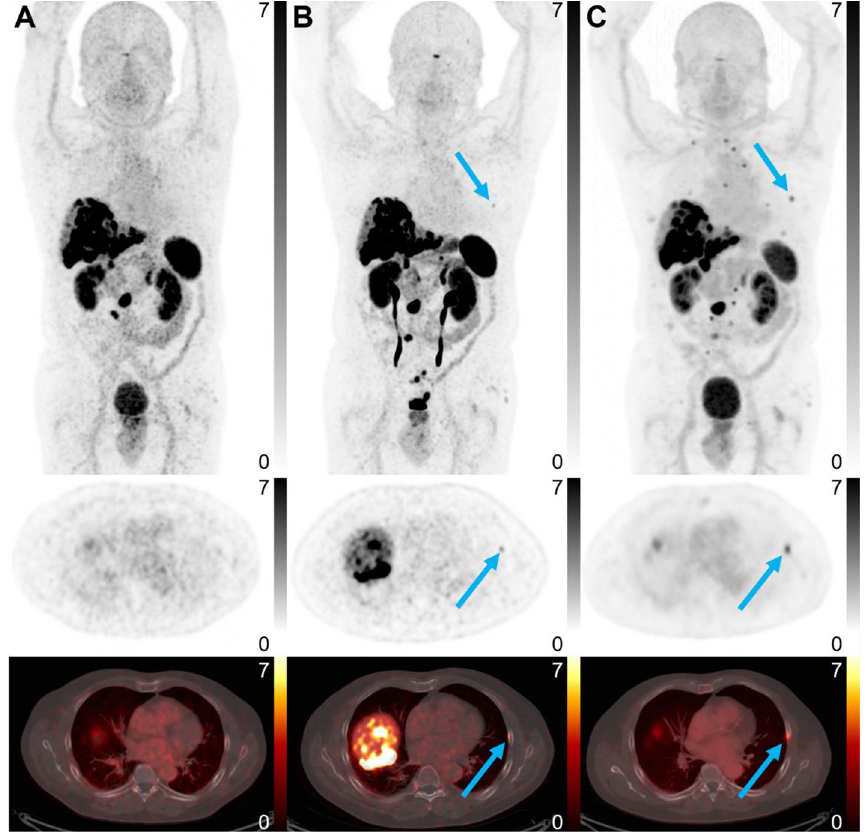
Fig. 4 A 68 Ga-DOTANOC and B 18 F-AlF-OC images (from top to bottom: maximum-intensity projection PET, transversal PET and fused PET/CT images, respectively) of a seventy-year old male patient with an intestinal neuroendocrine tumor with multiple liver metastases and one involved lymph node. 18 F-AlF-OC detected an additional bone lesion (blue arrow) that was confirmed by C follow-up 68 Ga-DOTANOC imaging 6 months later. Lookup tables apply to PET images (SUV). (From Pauwels et al.